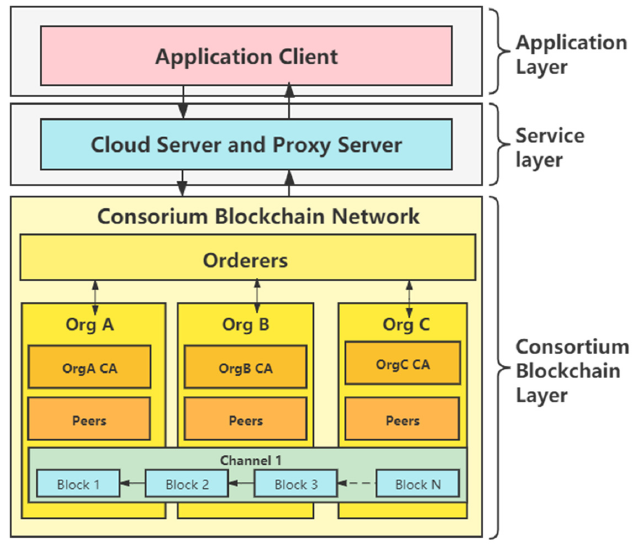
Figure 2. The consortium blockchain service center